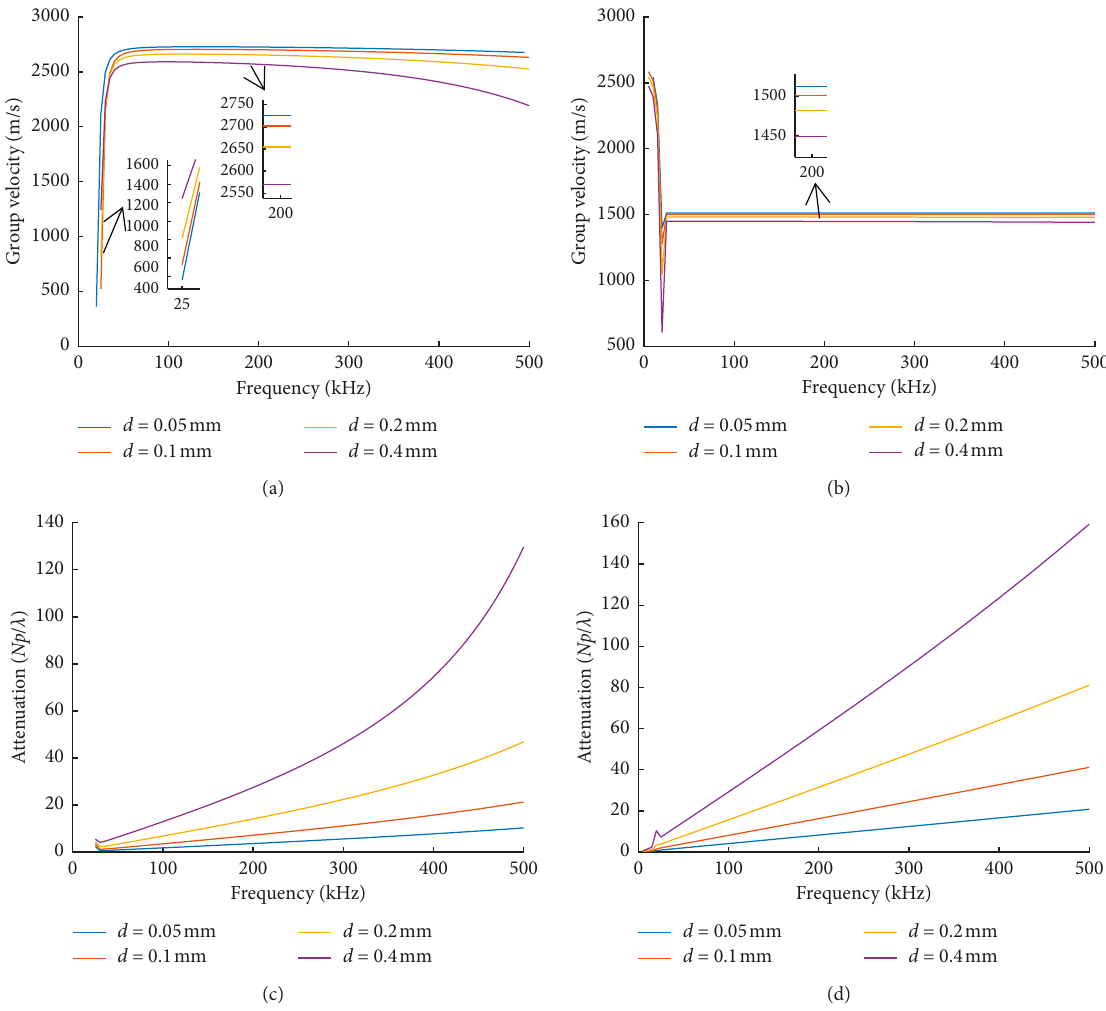
Figure 7: Group velocity and attenuation curves of the guided wave, d � 0.05mm, 0.1mm, 0.2mm, and 0.4 mm. (a) Group velocity curves of L ( 0 , 2 ) . (b) Group velocity curves of T ( 0 , 1 ) . (c) Attenuation curves of L ( 0 , 2 ) . (d) Attenuation curves of T ( 0 , 1 )